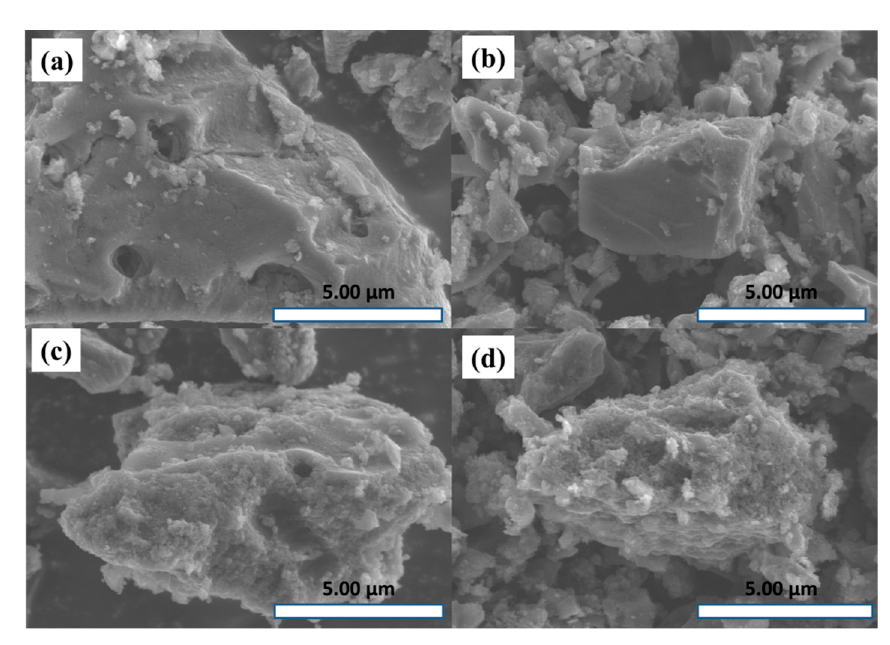
Figure 2. SEM images of ( a ) AC-o, ( b ) AC-s, ( c ) AC-a, and ( d ) AC-m.